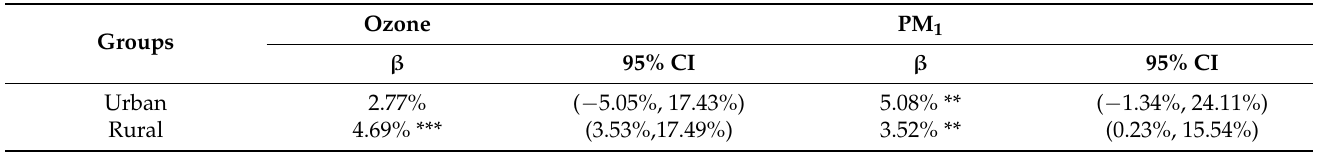
Table 6. Effects of ozone and PM 1 between urban and rural